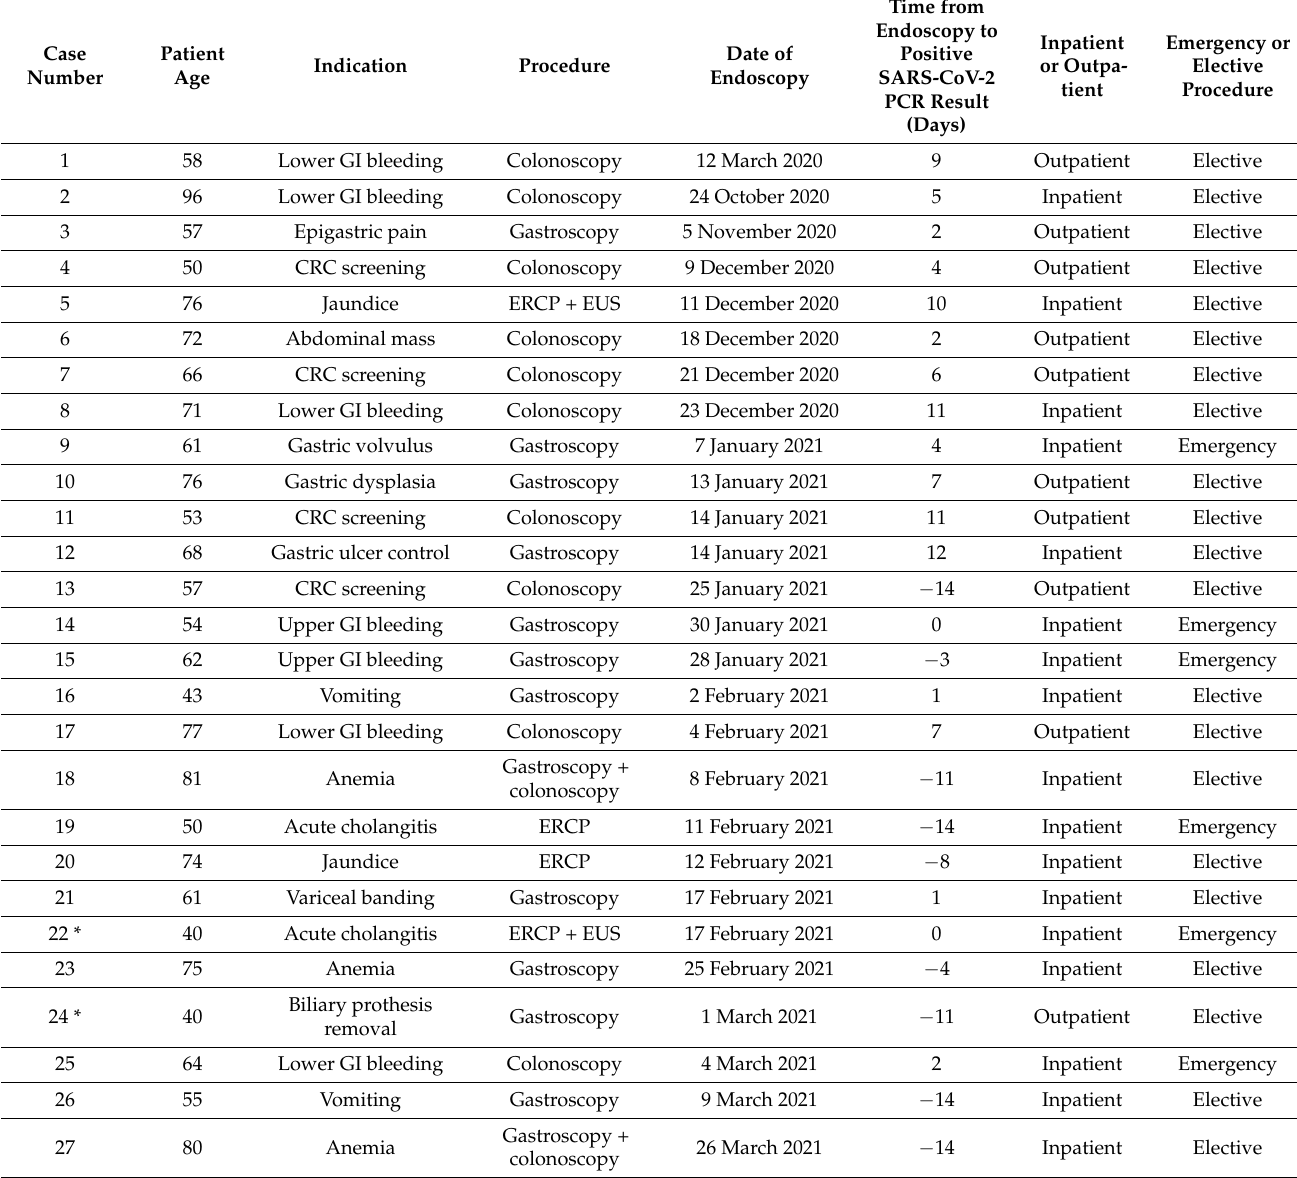
Table 1. Characteristics of patients with COVID-19 and the applied endoscopic